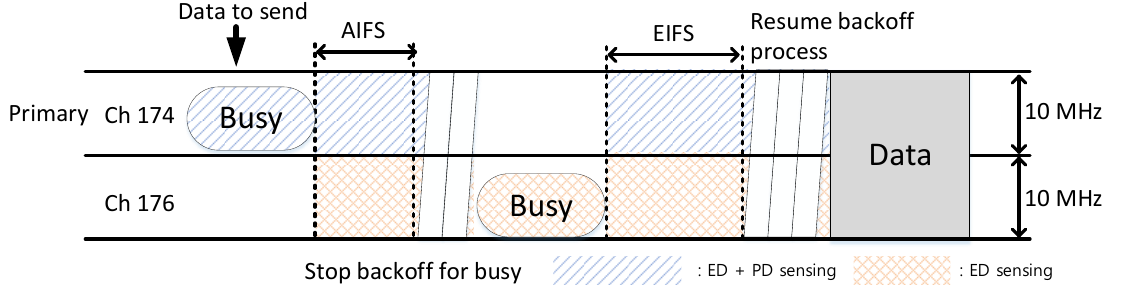
Figure 7. Alternative 20-MHz channel access scheme with all back-off approach for 20-MHz